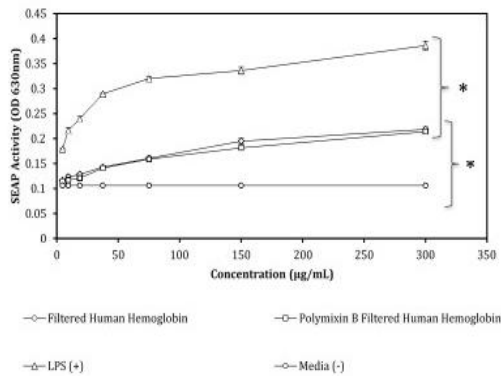
Figure 2. Hb-stimulated HEK-Blue hTLR4 cells in a dose-dependent manner. Total protein in each Hb preparation was assessed by 280 nm absorbance and standardized before application to the cells. Hb (Sigma) was first centrifuged, filtered (0.22 µ m), incubated on polymyxin B spin columns, and then incubated with HEK-Blue hTLR4 cells overnight (squares). Twenty µ L of media was removed from each well and mixed with the SEAP substrate. The reaction progressed for 30 min and the absorbance at 630 nm was assessed. Data shown is the mean of triplicate samples, and each point includes the standard error of the mean (SEM). Error bars that are not visible are present but fall within the range of the symbol. Standard linear regression analysis was performed, significant di ff erences between regressions were evaluated by ANOVA, and significance has been designated here by brackets and asterisks (*) where p < 0.05. HEK-Blue hTLR4 cells treated with (protein) adjusted aliquots of ligands, including Hb saved before polymyxin extraction (diamonds; slope = 0.00031; R 2 = 0.890), polymyxin treated Hb (squares; slope = 0.0003; R 2 = 0.89), LPS positive controls (triangles; slope = 0.00044; R 2 = 0.846), and media alone (circles; slope = 0.00030; R 2 = 0.90).